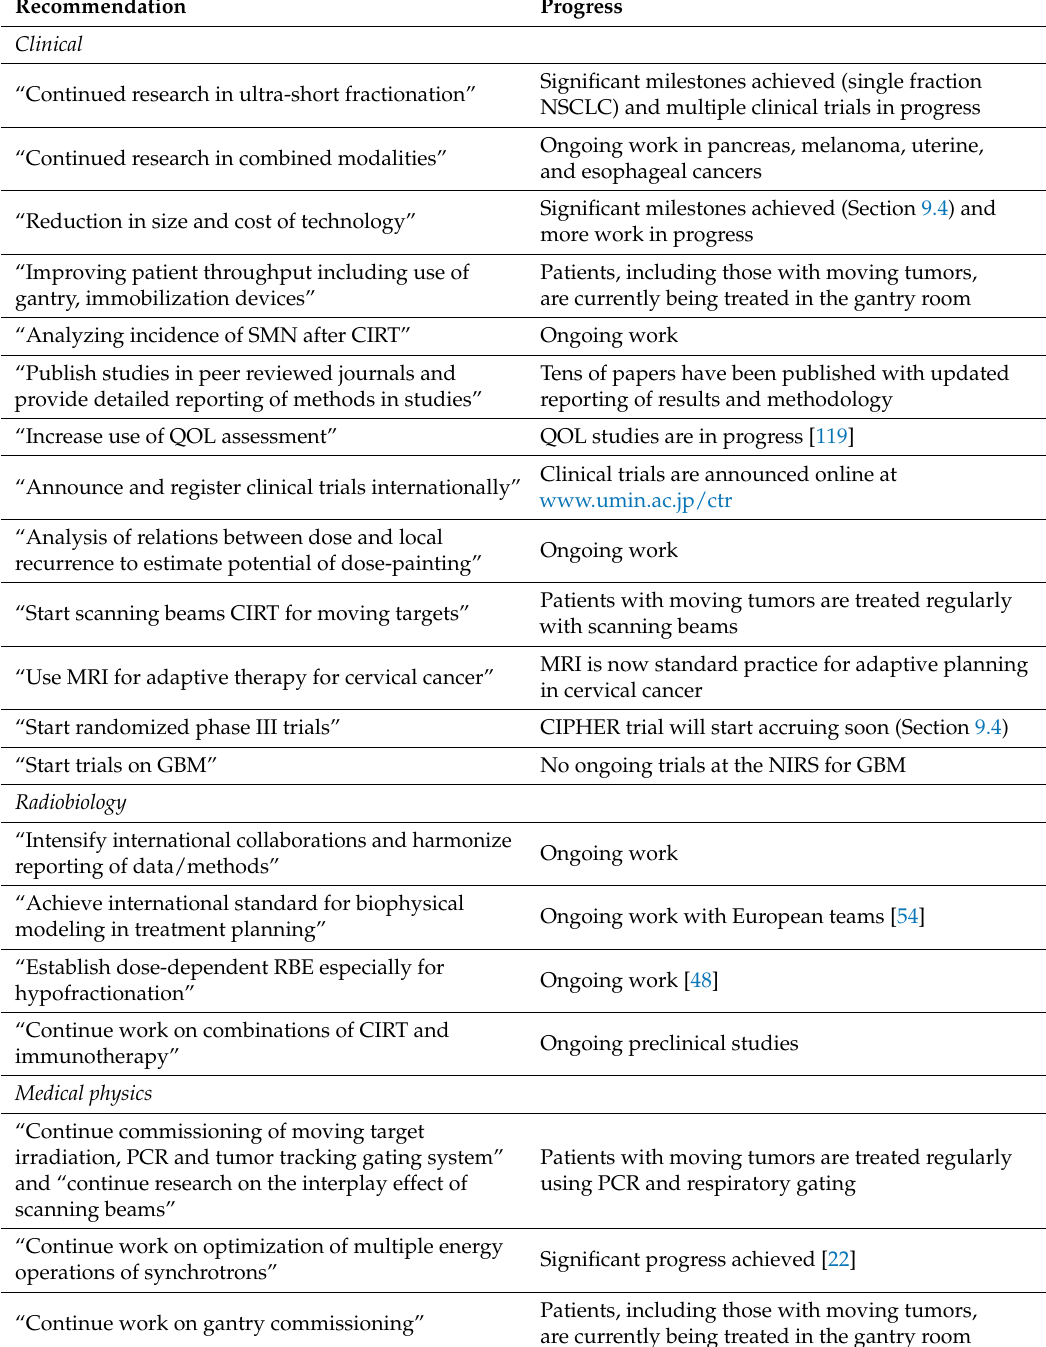
Table 4. A summary of recommendations of international experts to the NIRS and current